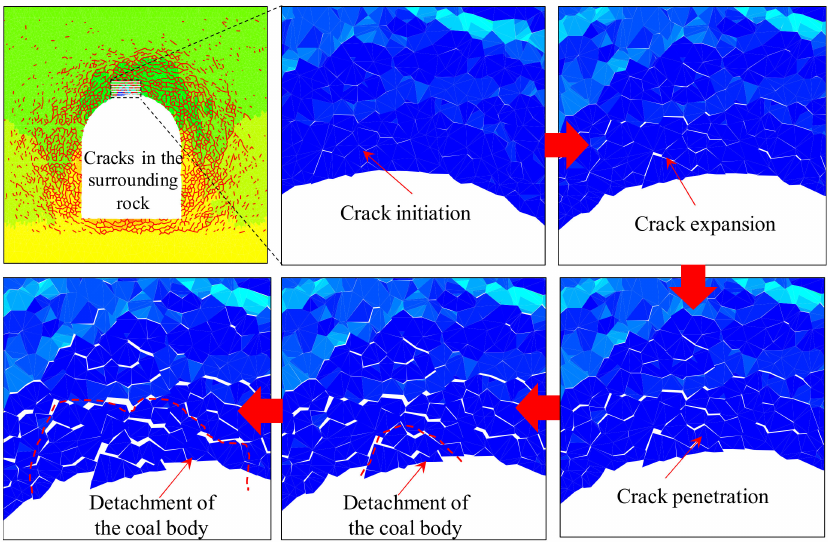
Figure 14. Roof fall mechanism of the chamber dome with